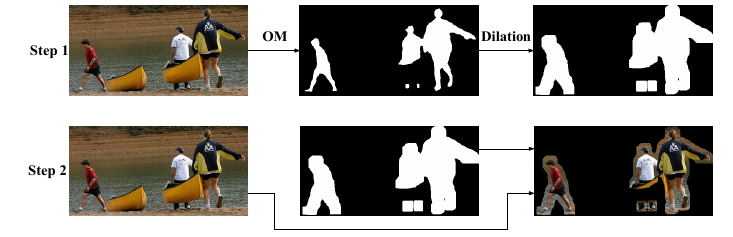
Figure 4. The procedure for combining DM with SM.